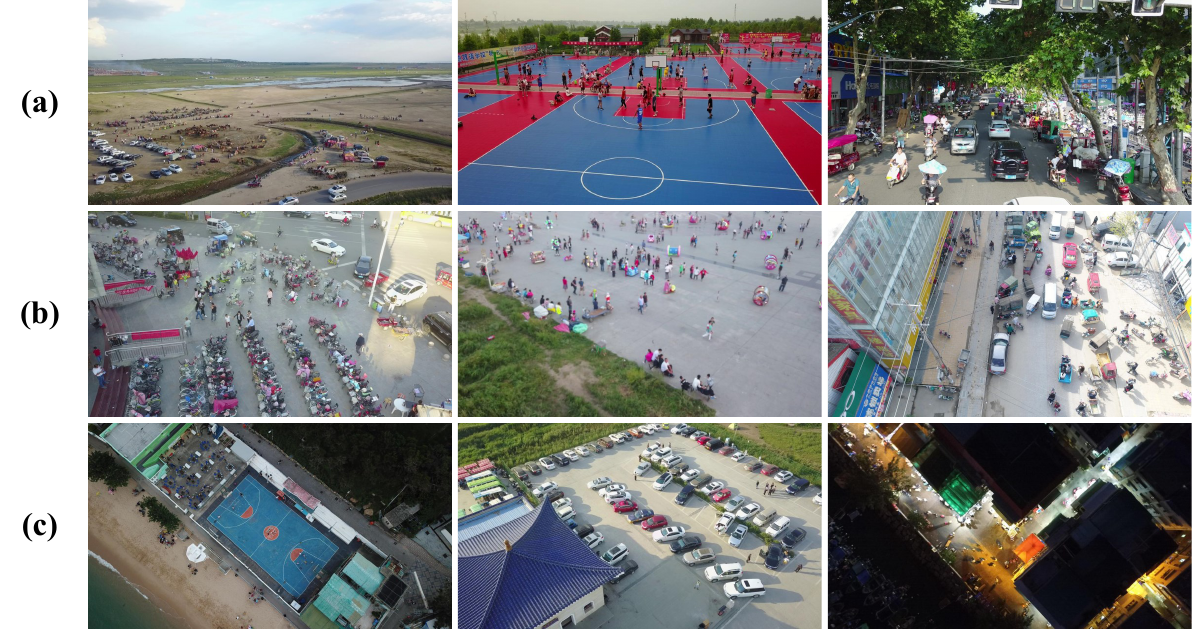
Figure 1. Intuitive cases to explain the three main problems in object detection in drone-captured images. The cases in row ( a ), ( b ), and ( c ), respectively, show the size variation, high-density, and large coverage of objects in drone-captured